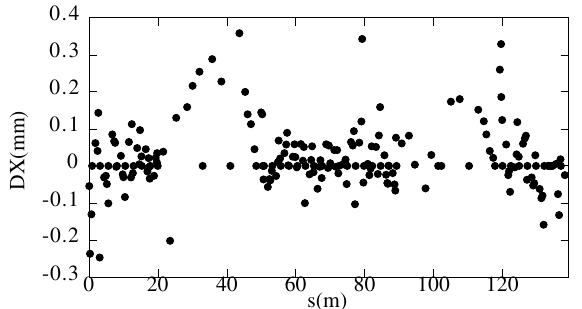
FIG. 1. Measured horizontal misalignment with respect to bending magnets.